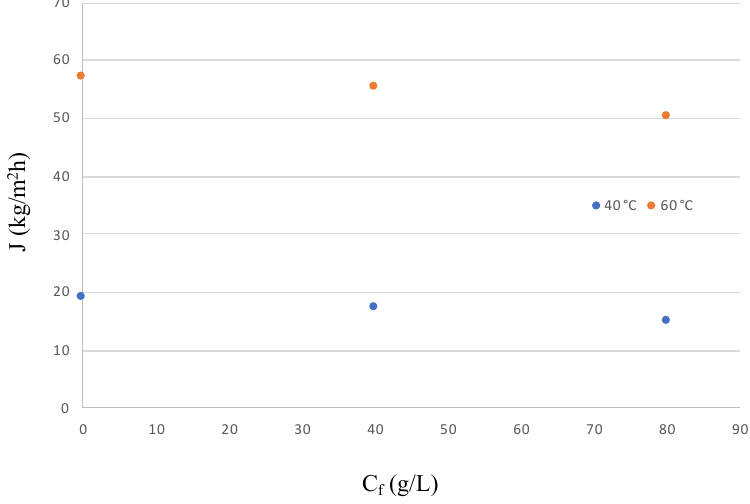
Figure 12. VMD tests. Effect of feed temperature and concentration on the flux.